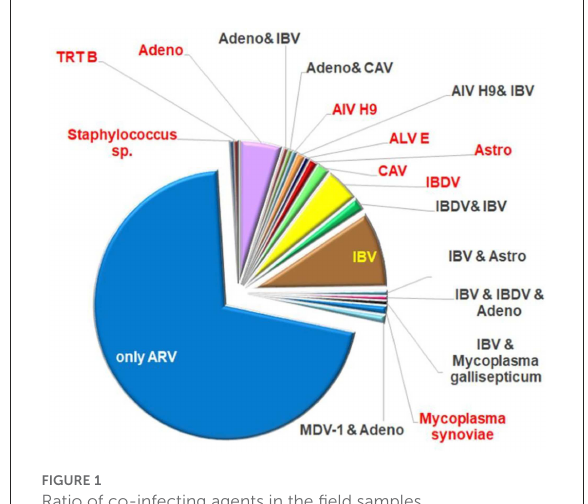
FIGURE1 Ratio of co-infecting agents in the field